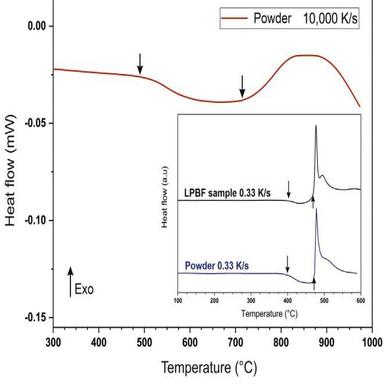
FDSC scan of AMZ4 powder measured at a heating rate of 10,000 K/s. The inset shows conventional DSC results of the powder and LPBF sample measured at a heating rate of 0.33 K/s (20 K/min). The arrows indicate the onsets of glass transition and crystallization (see also Table 1).